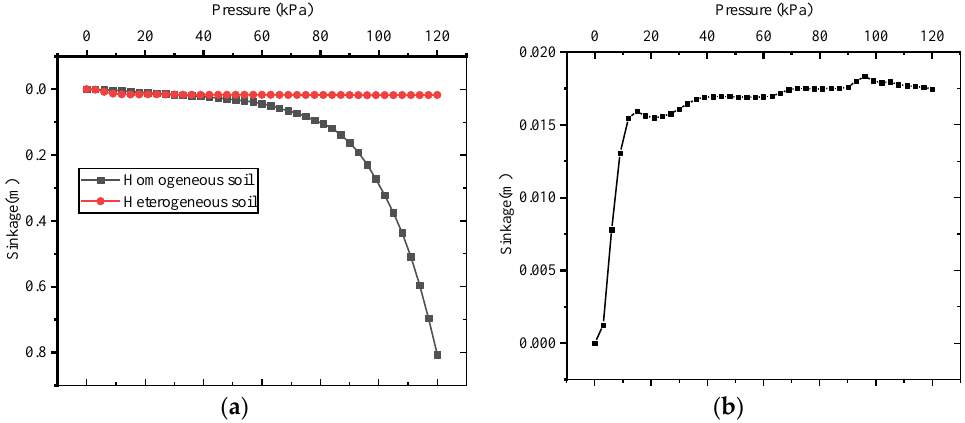
Figure 33. ( a ) Pressure-sinkage curves under different conditions and ( b ) curve under the heteroge- neous soil conditions.